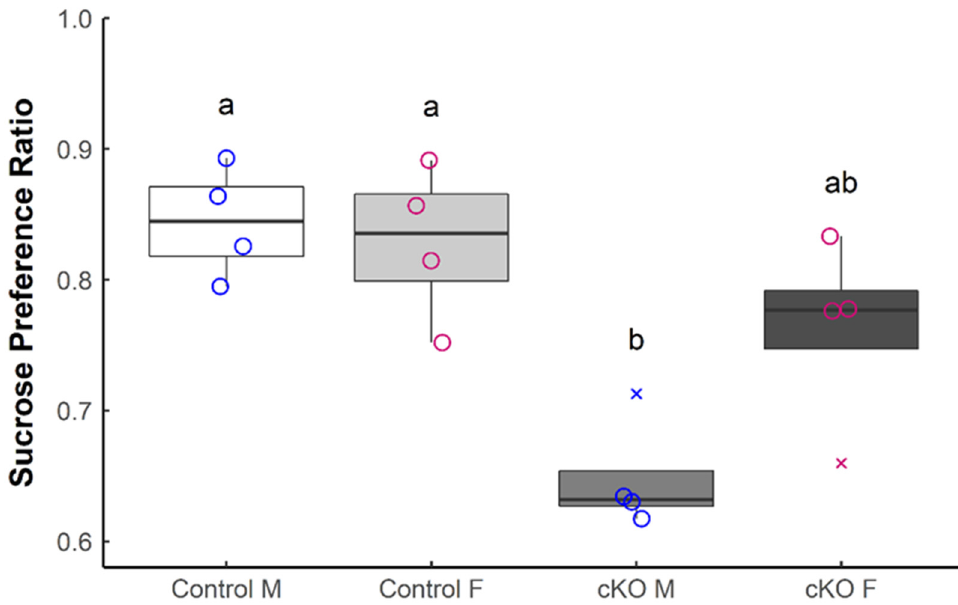
Figure 4. Sox2 ablation reduces sucrose preference in male mice. The sucrose preference ratio during the test phase was determined for Sox2 cKO mice ( n = 8) and littermate controls ( n = 8). Males (M) and females (F) are considered separately. Female mice are denoted in pink and male mice are denoted in blue. Outliers are denoted by cross marks. Statistical significance from 2-way ANOVA with Tukey’s Post hoc test is represented by letter differences ( p < 0.05).